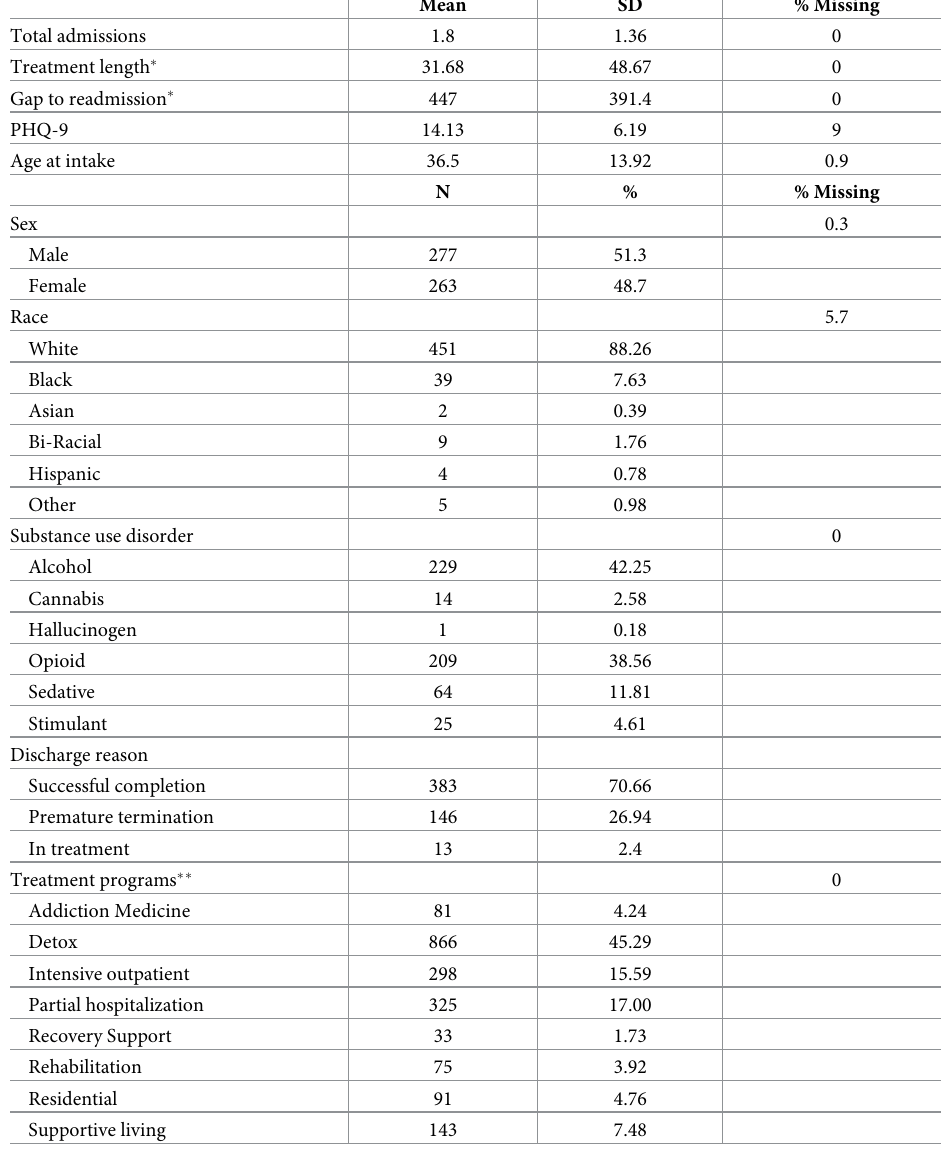
Table 1. Descriptive statistics for first treatment